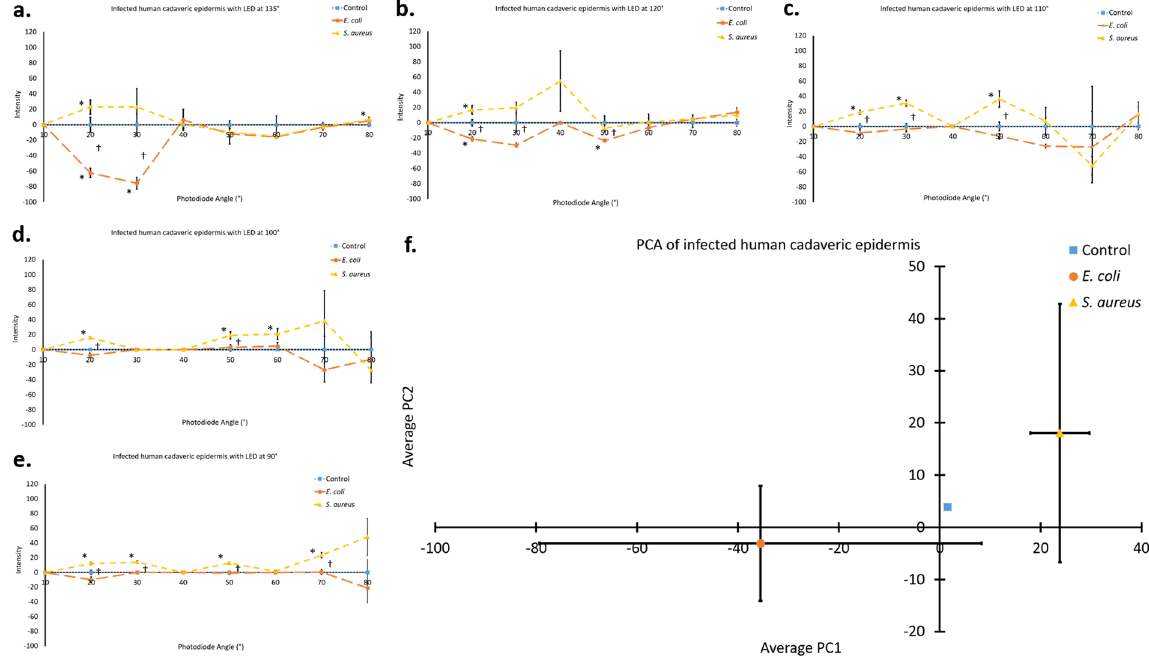
Figure 7. Identification of bacteria on a human cadaveric epidermis. ( a – e ) Data obtained from the photodiode array designed by scanning human cadaveric epidermis samples inoculated with sterile LB, E. coli , or S. aureus . Incident light angle was changed for each of the five data sets; 135° ( a ), 120° ( b ), 110° ( c ), 100° ( d ), and 90° ( e ). At each individual incident light angle, significant differences result between bacterial inoculation and control samples as well as between each species of inoculation; E. coli or S. aureus . As expected, the trend changes as the incident light angle changes, but distinct differences are maintained despite changing trends with changing incident angles. One data point is considered to be the average of 12 readings from each photodiode (3 s scan). ( f ) Principle component analysis (PCA) of the data shown in ( a – e ) shows distinct differences between infections of the human cadaveric epidermis with E. coli vs. S. aureus vs. only the commensal bacteria present on control samples. The two principle components shown, PC1 and PC2, account for 70% of the data shown in ( a – e ), 49% and 21% for PC1 and PC2, respectively. Adding an additional PC, PC3 would account for an additional 14% of the data shown in ( a – e ). Each of 2 human cadaveric epidermis samples was scanned at three unique locations for 3 s at each location. Error bars represent standard error of the mean, the control group of ( f ) has standard error of zero. * is shown to the left side of each data point indicating significant difference (p < 0.05) between E. coli vs. control samples or between S. aureus vs. control samples. † is shown to the right side of each data point indicating significant difference (p < 0.05) between E. coli vs. S. aureus